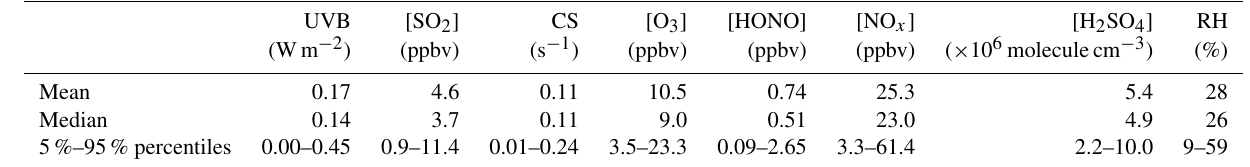
Table 1. Mean, median, and 5%–95% percentiles of key atmospheric variables and [H 2 SO 4 ] during the daytime. UVB [SO 2 ] CS [O 3 ] [HONO] [NO x ] [H 2 SO 4 ] RH (ppbv) (ppbv) (ppbv) (%) Mean 0.17